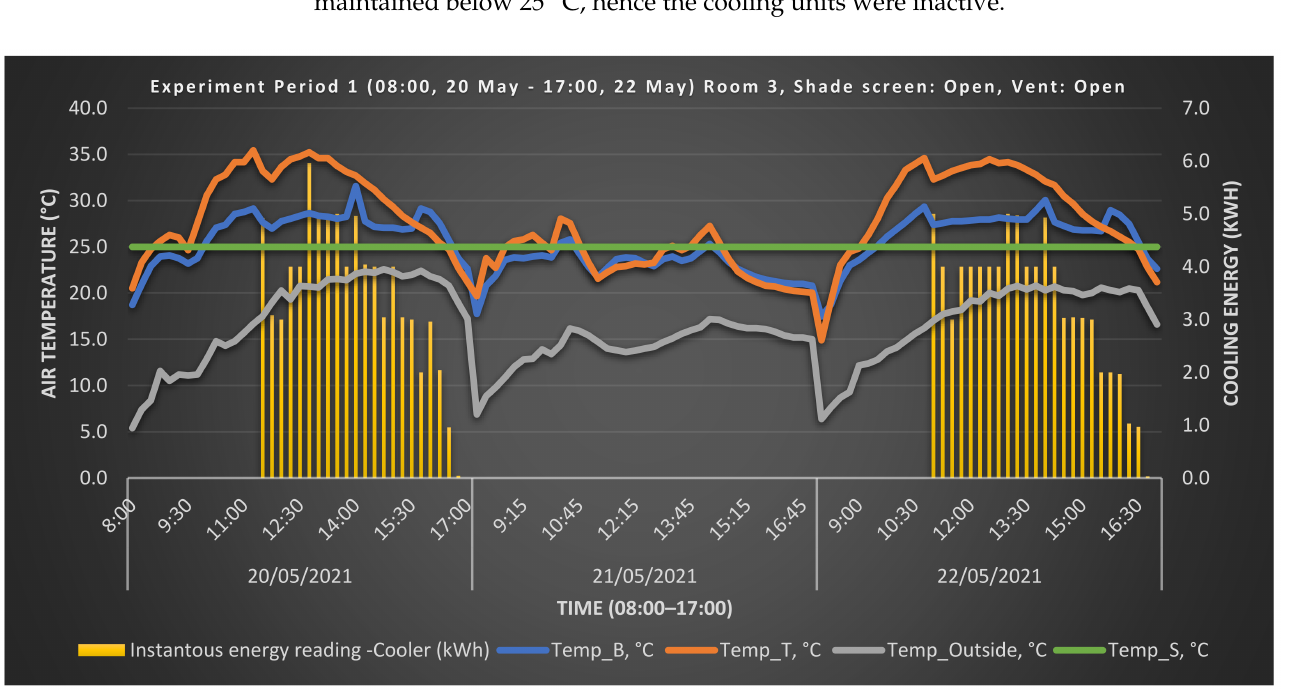
Figure 2. Temperature and energy use in different vent and shade screen status in experimental Period 1. Air temperatures collected at the base (B), top (T), and outside are depicted in blue, orange, and white lines respectively. Energy use measured by mechanical coolers is depicted over time using yellow bars along with air